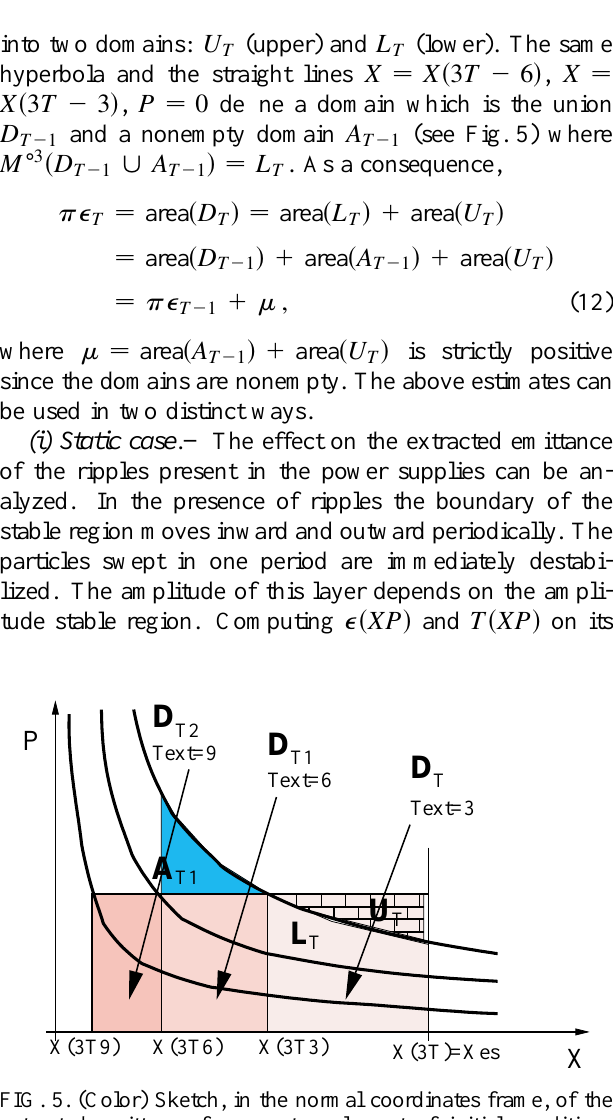
into two domains: U T (upper) and L T (lower). The same hyperbola and the straight lines X (cid:1) X (cid:2) 3 T 2 6 (cid:3) , X (cid:1) X (cid:2) 3 T 2 3 (cid:3) , P (cid:1) 0 define a domain which is the union D T 2 A T 2 1 and a nonempty domain 1 (see Fig. 5) where